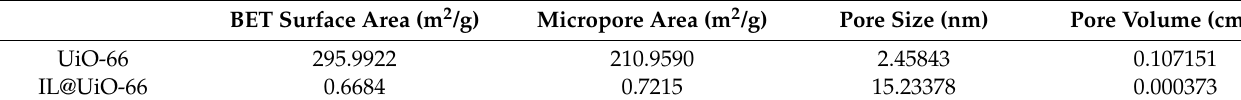
Table 1. Tabulation of the surface area analysis of UiO-66 and IL@UiO-66. BET Surface Area (m 2 /g)